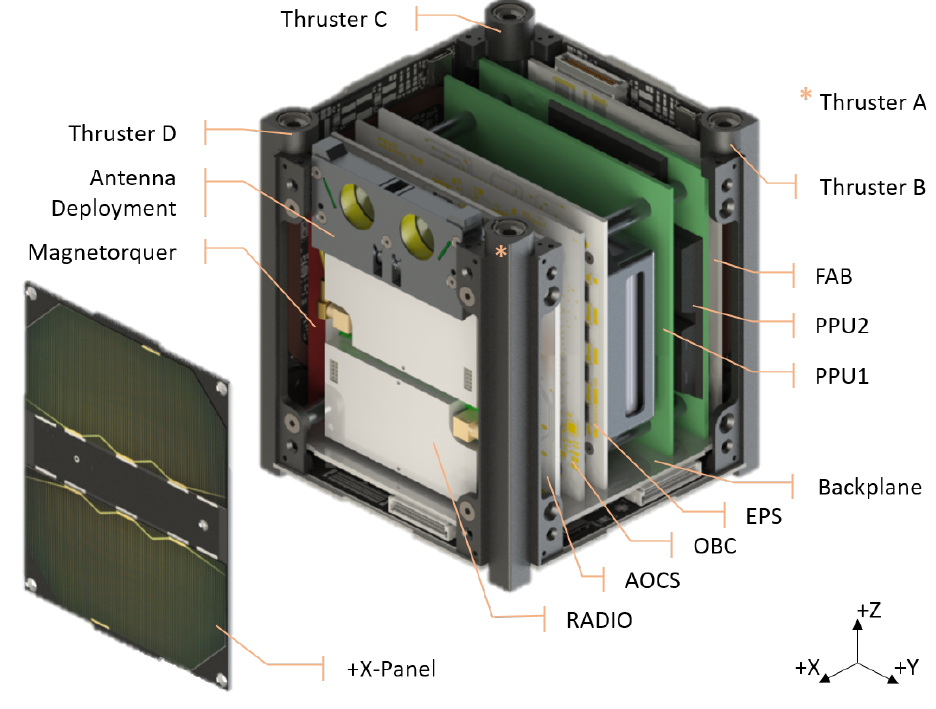
Figure 2. A CAD model of the UWE-4